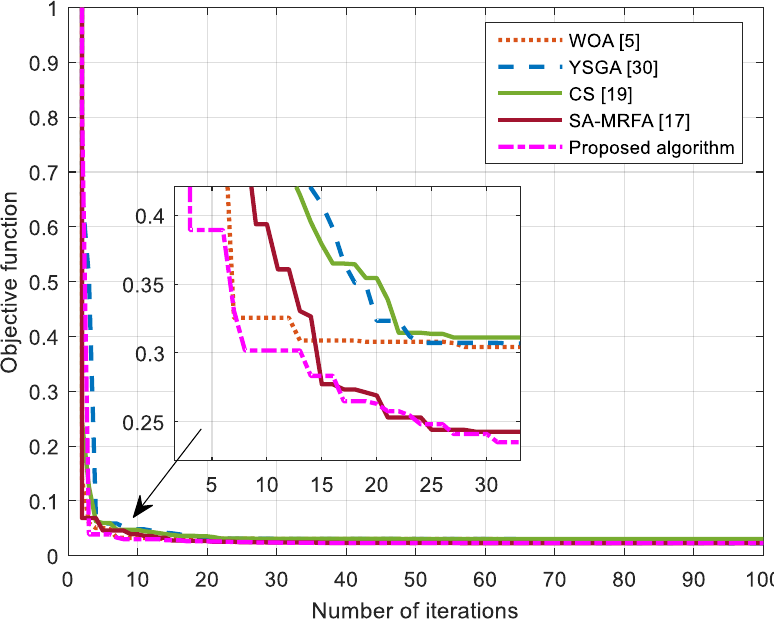
Figure 18. Mean results of the convergence characteristics over 30 independent runs.